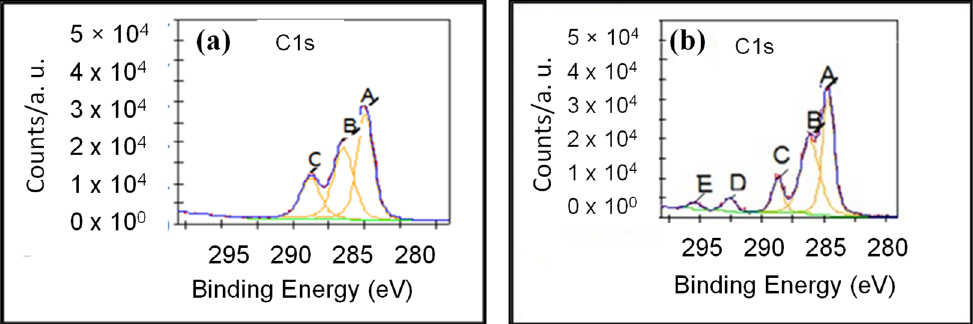
Figure 4. ( a ) C(1s) XPS Spectra of p(HEMA) and ( b ) p(HEMA-co-AGE) cryogels.